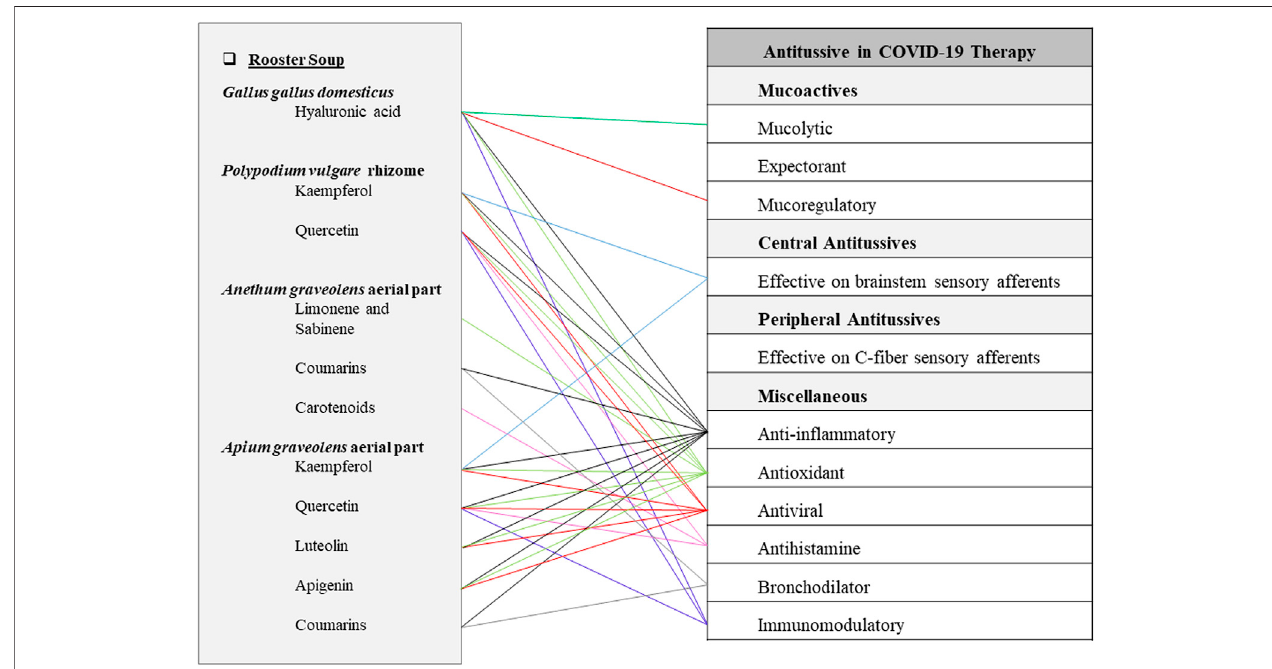
FIGURE 4 | Potentials of rooster soup as an antitussive Persian functional food in COVID-19